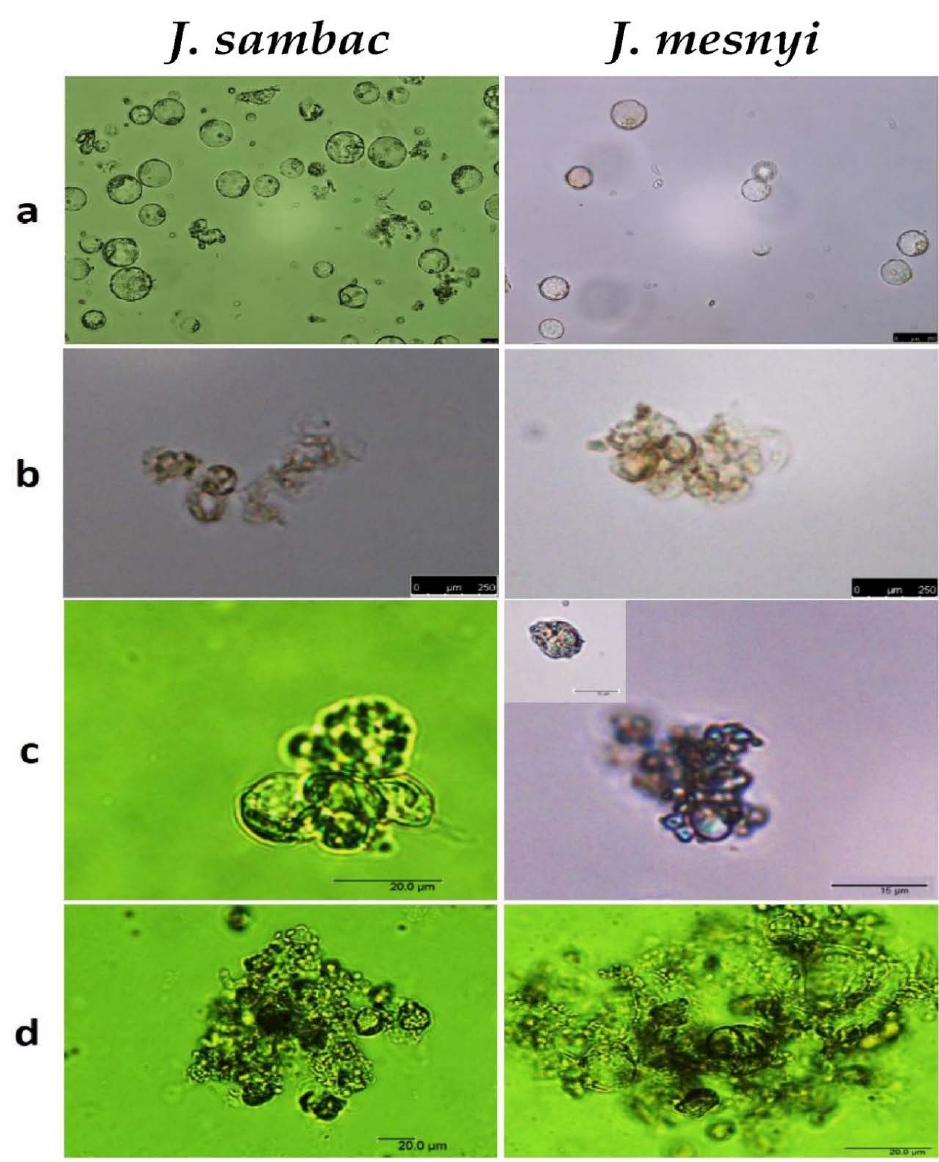
Figure 7. General overview of protoplast culture for J. sambac and J. mesnyi . ( a ) Isolated protoplast from callus tissues, bar 100 µm, ( b ) first division of protoplast after two days of culture, bar 200 µm, ( c ) second division of protoplast after seven days of culture, bar 50 µm, ( d ) protoplast-derived microcolony formation after three weeks of culture, bar 100 µm.